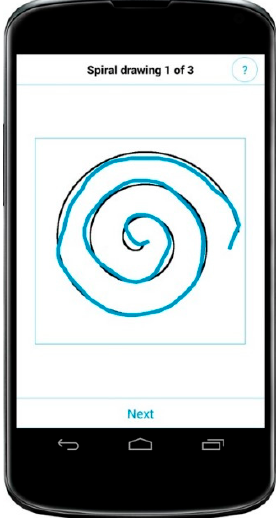
Figure 1. Implementation of a fine motor test (spiral drawing) on the smartphone.